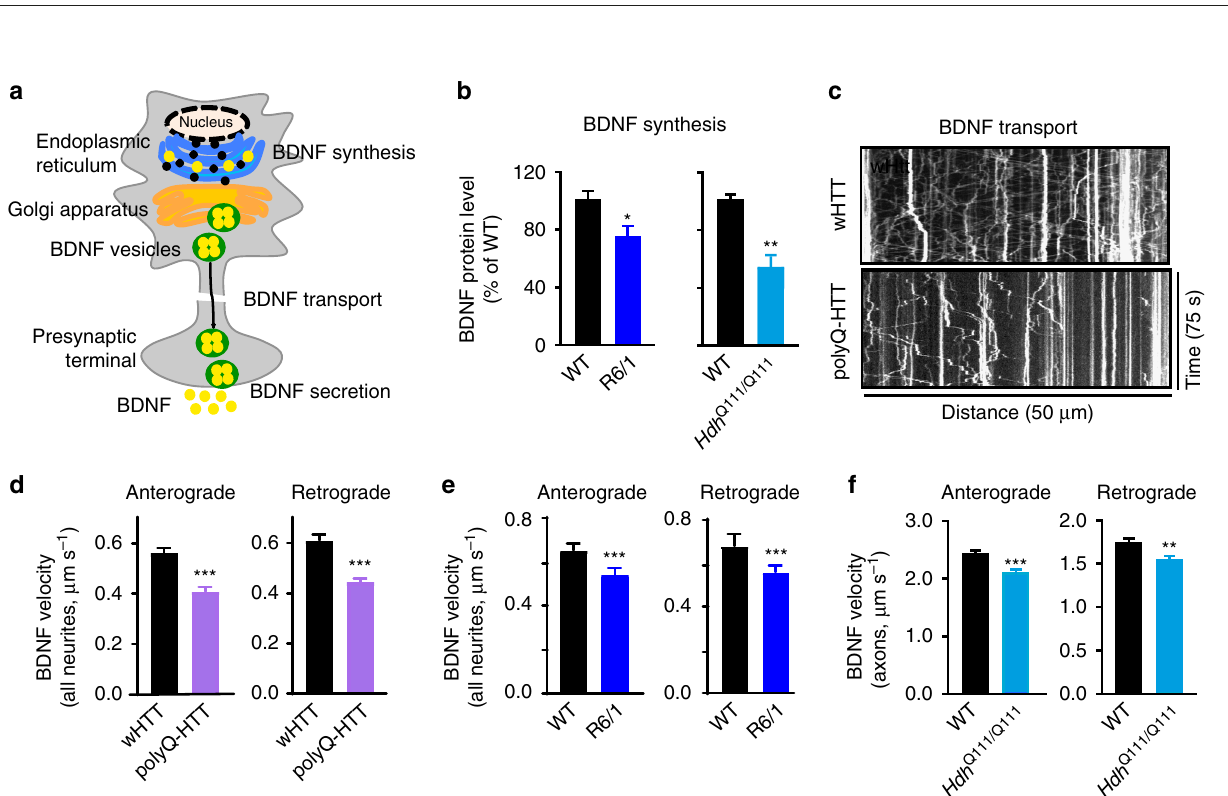
Fig. 1 Deregulated GluA2-and GluA1-AMPAR surface diffusion in fi ve complementary HD cellular models. a Experimental scheme for endogenous GluA2- and GluA1-AMPAR surface tracking using quantum dot (QD). b Typical GluA2-QD trajectories (magenta) in hippocampal neurons expressing vector, exon1-wHTT, and exon1-polyQ-HTT, respectively. Lower panels represent enlarged GluA2-QD trajectories. Scale bars, 10 μ m. c , e , g, i , k Top panels, GluA2-AMPAR diffusion coef fi cients (median ± 25 – 75% interquartile range (IQR)) in rat hippocampal neurons expressing vector, exon1-wHTT, and exon1- polyQ-HTT; n = 844, 382, and 695 trajectories, respectively ( c ), in rat hippocampal neurons expressing FL-wHTT or FL-polyQ-HTT; n = 603 and 760 trajectories, respectively ( e ), in hippocampal neurons from R6/1 mice and WT littermate controls; n = 1885 and 1994 trajectories, respectively ( g ), in hippocampal neurons from Hdh Q111/Q111 mice and WT littermate controls; n = 1571 and 886 trajectories, respectively ( i ), and in hippocampal neurons from CAG140 mice and WT littermate controls; n = 2939 and 5457 trajectories, respectively ( k ). d , f , h , j , l Top panels, GluA1-AMPAR diffusion coef fi cients (median ± 25 – 75% IQR) in rat hippocampal neurons expressing vector, exon1-wHTT, and exon1-polyQ-HTT; n = 9337, 8320, and 10905 trajectories, respectively ( d ), in rat hippocampal neurons expressing FL-wHTT or FL-polyQ-HTT; n = 4331 and 6462 trajectories, respectively ( f ), in hippocampal neurons from R6/1 mice and WT littermate controls; n = 18565 and 14195 trajectories, respectively ( h ), in hippocampal neurons from Hdh Q111/Q111 mice and WT littermate controls; n = 5612 and 5844 trajectories, respectively ( j ), and in hippocampal neurons from CAG140 mice and WT littermate controls; n = 8569 and 9170 trajectories, respectively ( l ). Bottom panels, cumulative probability of GluA2 and GluA1 diffusion coef fi cient of respective top panel. The fi rst point of the probability corresponding to the fraction of immobile receptors with diffusion coef fi cients ≤ 0.01 μ m 2 s − 1 shown by arrows. Note that the cumulative curve shifts toward right indicating an increased GluA2 and GluA1 surface diffusion. Data were from 6 to 12 cells from three separate experiments. Signi fi cance was determined by Kruskal – Wallis test followed by Dunn ’ s multiple comparison test ( c , d ) or two-tailed Mann – Whitney test ( e – l ); *** P <